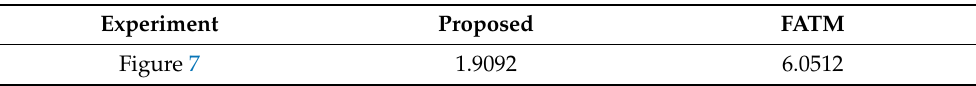
Table 4. Average position errors (in pixels) of the entire Figure 7